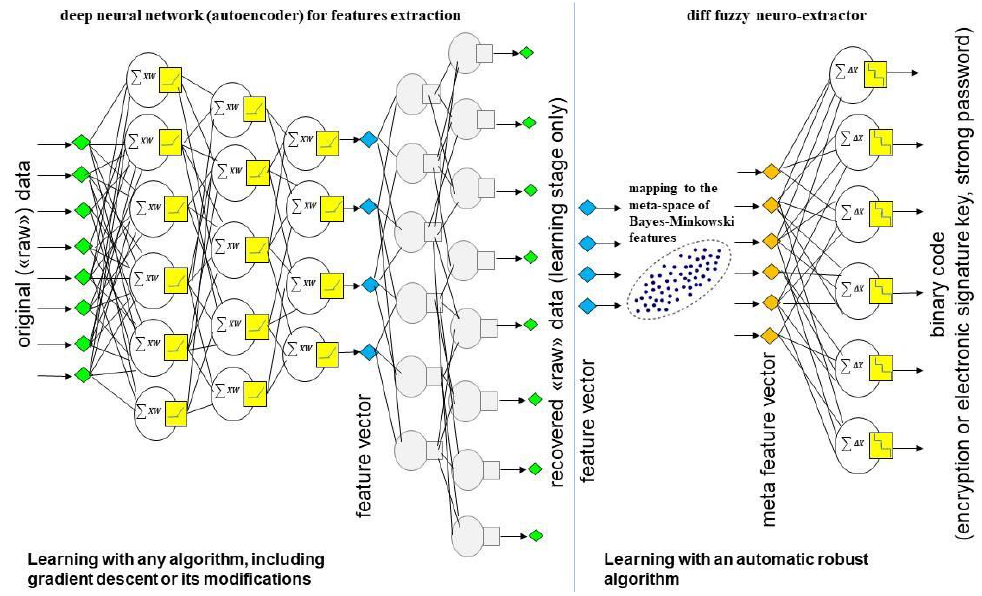
Figure 1. Block diagram of biometric-based key binding.